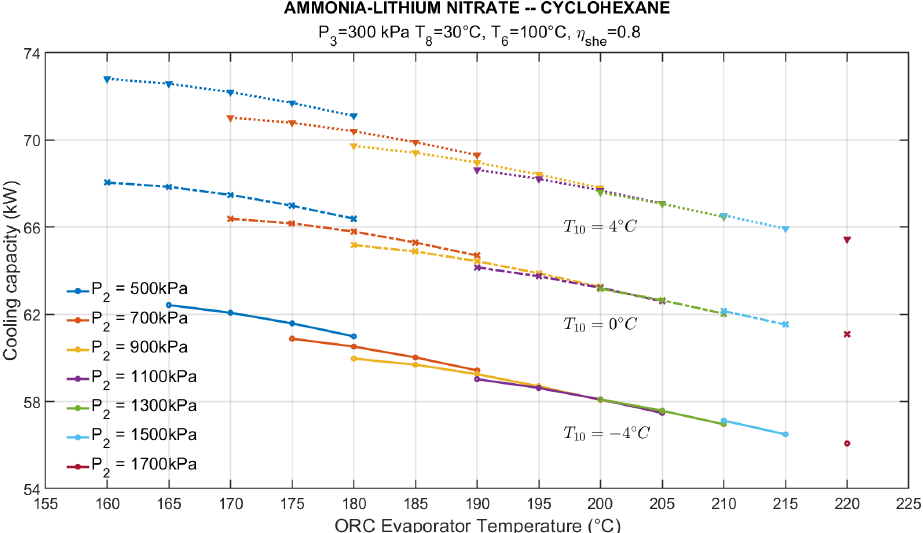
Figure 7. NH 3 -LiNO 3 -- C 6 H 12 e ff ect of heat source and cooling temperatures on cooling load.